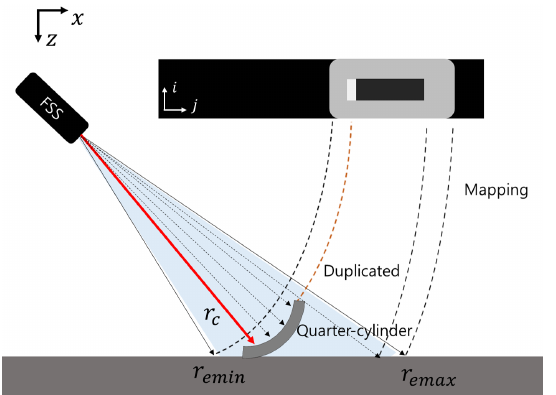
Figure 2. Acoustic beam geometry and image generation of the FLS in a 2D vertical